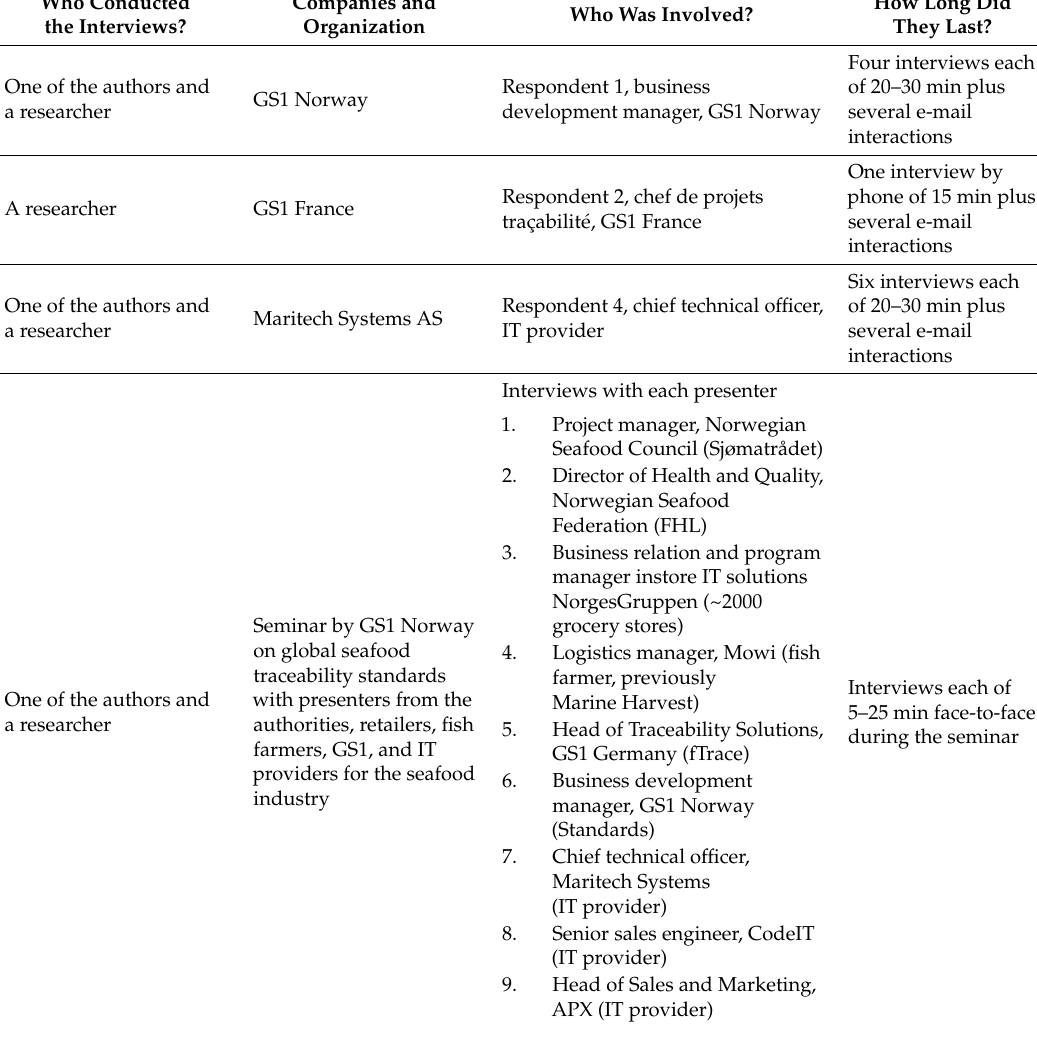
Table A1. Interviews, actors involved, and number and length of